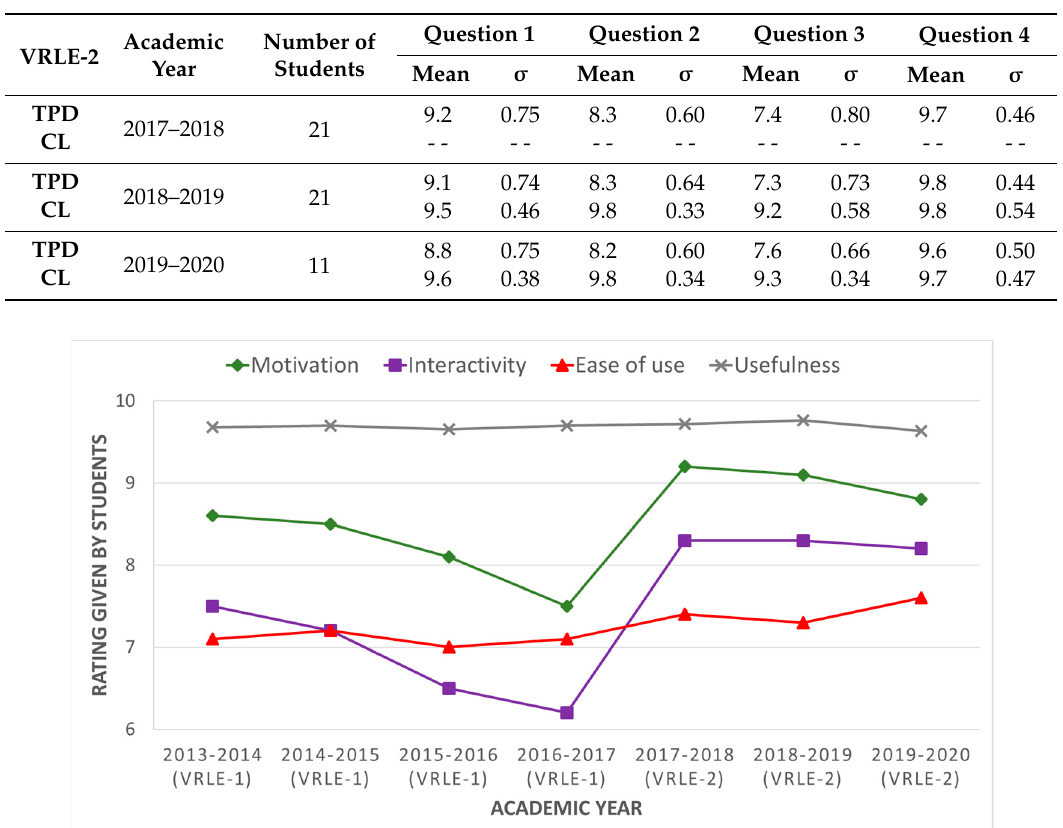
Figure 6. KPIs values of the VRLE of TPD over a period of academic years (former version, VRLE-1, and later version, VRLE-2).